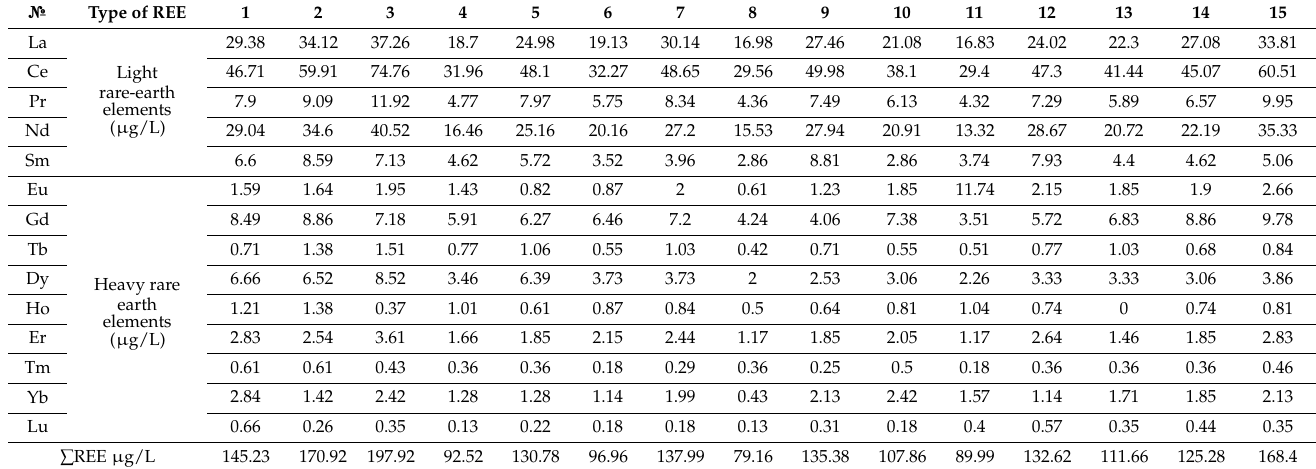
Figure 7. Distribution profile of rare-earth elements in lake water within Burabay rock mass (river- water Clarke is normalized). Figure 8. Distribution profile of rare-earth elements in lake water within Burabay rock mass (sea water Clarke is normalized).